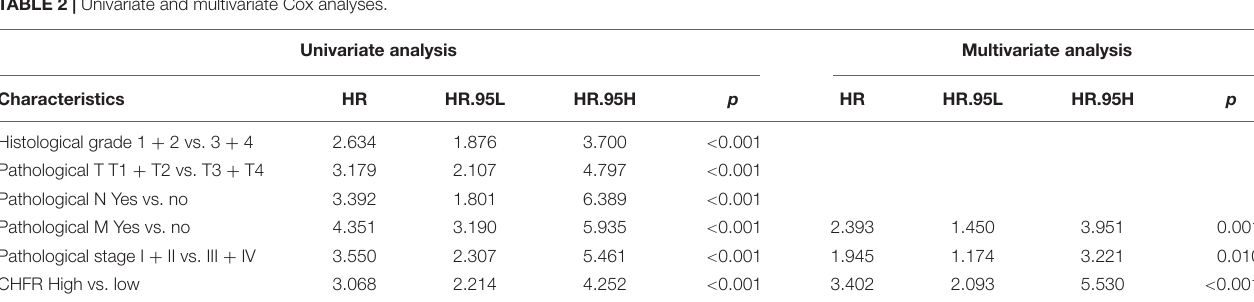
FIGURE 3 | Identification of CHFR overexpression is associated with poor prognosis of ccRCC: (A–C) CHFR that was upregulated in ccRCC patients related to a shorter OS, PFI, and DSS survival based on TCGA dataset. (D) The time-dependent ROC for 1-, 3-, and 5-year OS predictions for the CHFR prognostic signature. (E) CHFR gene expression in ccRCC adjacent normal tissues and tumor tissues according TCGA dataset. (F–J) CHFR expression was analyzed in ccRCC patients regarding histological grade, pathological T, pathological N, pathological M, and pathological stage. (K) ROC curve analysis of CHFR as individual biomarkers to discriminate ccRCC patients with distant metastasis form patients without distant metastasis. (L) ROC curve analysis of CHFR as individual biomarkers to discriminate ccRCC patients in pathological stages III and IV from patients in pathological stages I and II. TABLE 2 | Univariate and multivariate Cox